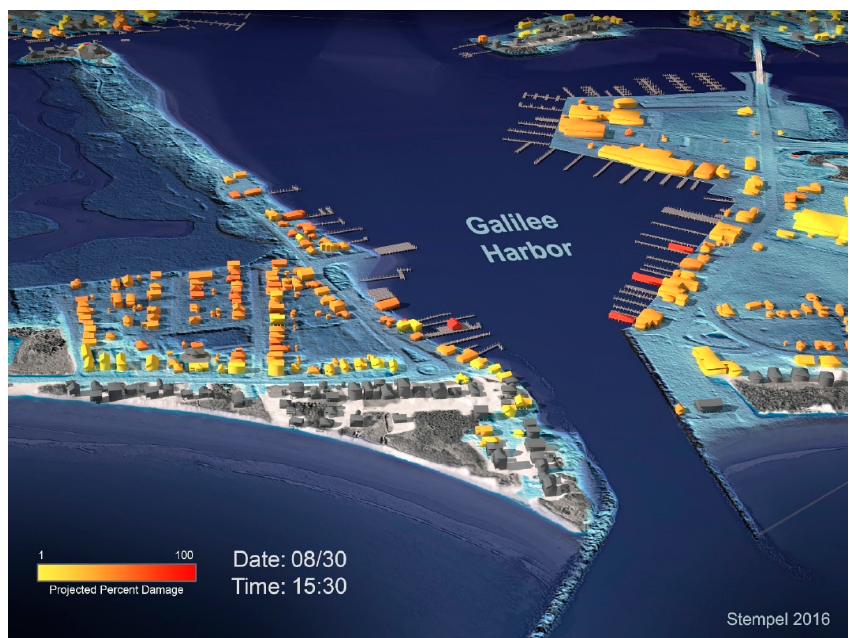
Figure 1. Excerpt from time incremented 3D hazard visualization series of Galilee Harbor, South Kingstown, RI, USA, depicting the progressive impacts (%structural value) of Hurricane Carol (1954) at current sea level on present build-out. The impact modeling system used to drive this visualization is currently adapted to real-time deployment for use by emergency managers. Image: Authors.